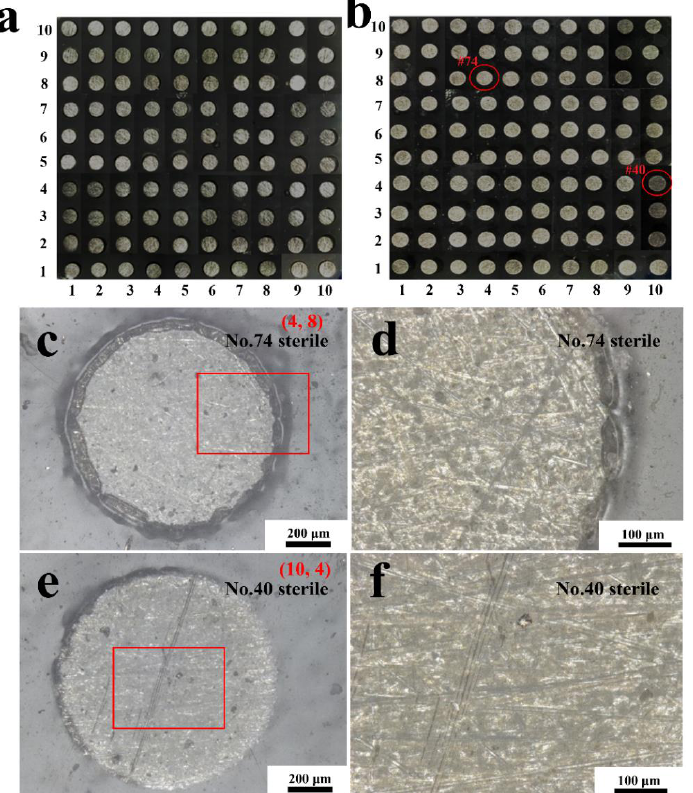
Figure 9. The handheld digital microscope images of the entire WBE surface at the initial state ( a ) and after the immersion in a sterile liquid medium for 14 days ( b ). The morphologies of the #74 electrode surface and its magnification ( c,d ) and #40 electrode surface and its magnification ( e,f ) after 14 days of immersion.